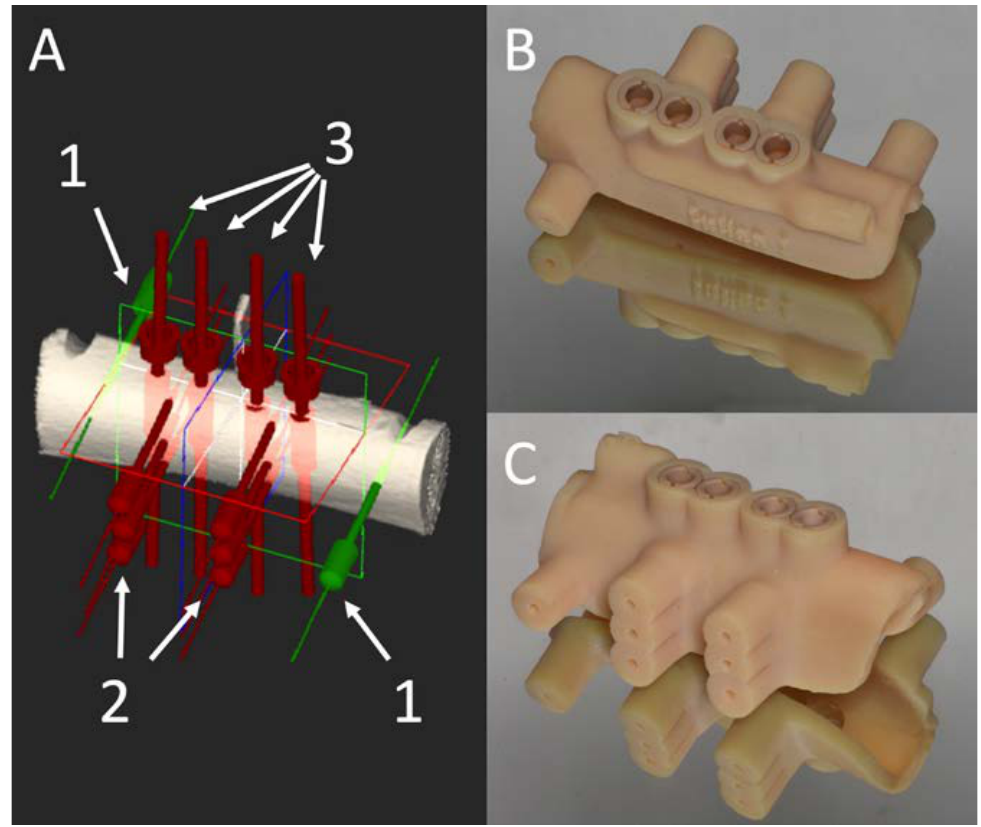
Figure 1. Virtual planning ( a ) and images of both sides (( b ) and ( c )) of one of the 3D-printed guides utilized in the experiment. ( 1 ) Fixation pins; ( 2 ) thermocouple drill holes; ( 3 ) implant positions. An acrylic (MED620) 3D-printed surgical guide (NaviGUIDE ® , Biomax S.p.a., Vicenza, Italy) was then produced for each rib, according to the individual planning using an Objet30 OrthoDesk (Stratasys, Ltd., Eden Prairie, MN, USA) printer. The axes resolution was 600 dpi, 600 dpi and 900 dpi for X-, Y- and Z-axes